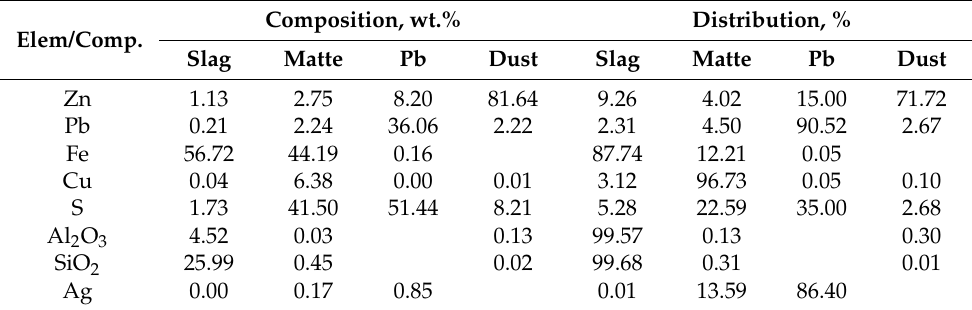
Table 10. Results of smelting tests, with jarosite-PbAg sludge sulfidized with the addition of sulfur and carbon. Table 9. Results of smelting tests, jarosite-PbAg sludge sulfidized with the addition of sulfur. Elem/Comp. Elem/Comp.